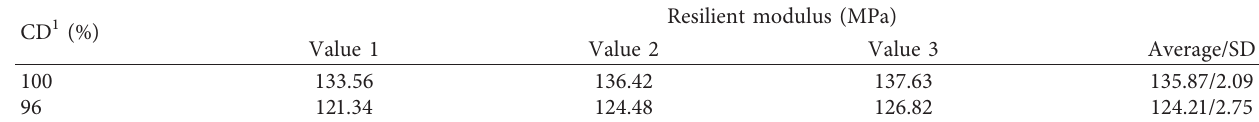
Table 2: Results of resilient modulus test.